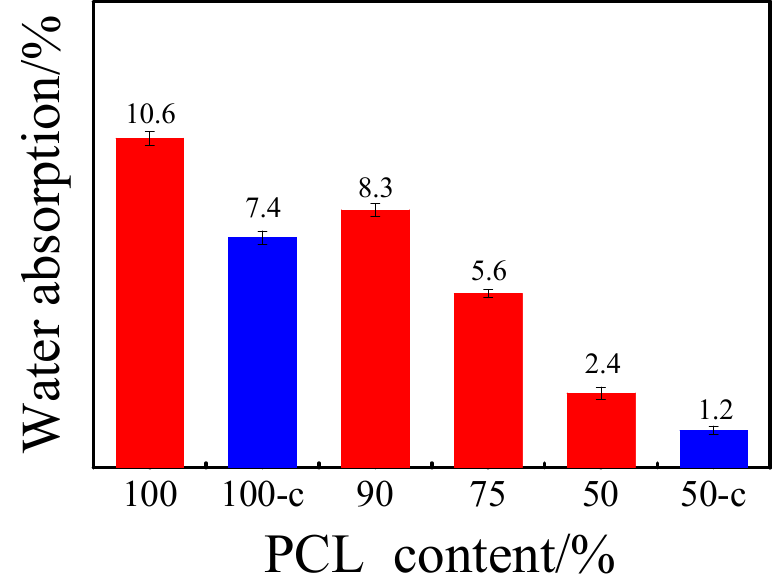
Figure 7. Water absorption of PA6 and P(CLA -co- CLO) copolymers. 100-c and 50-c are crystallized samples (firstly isothermally crystallized at 160 °C and then at 40 °C).